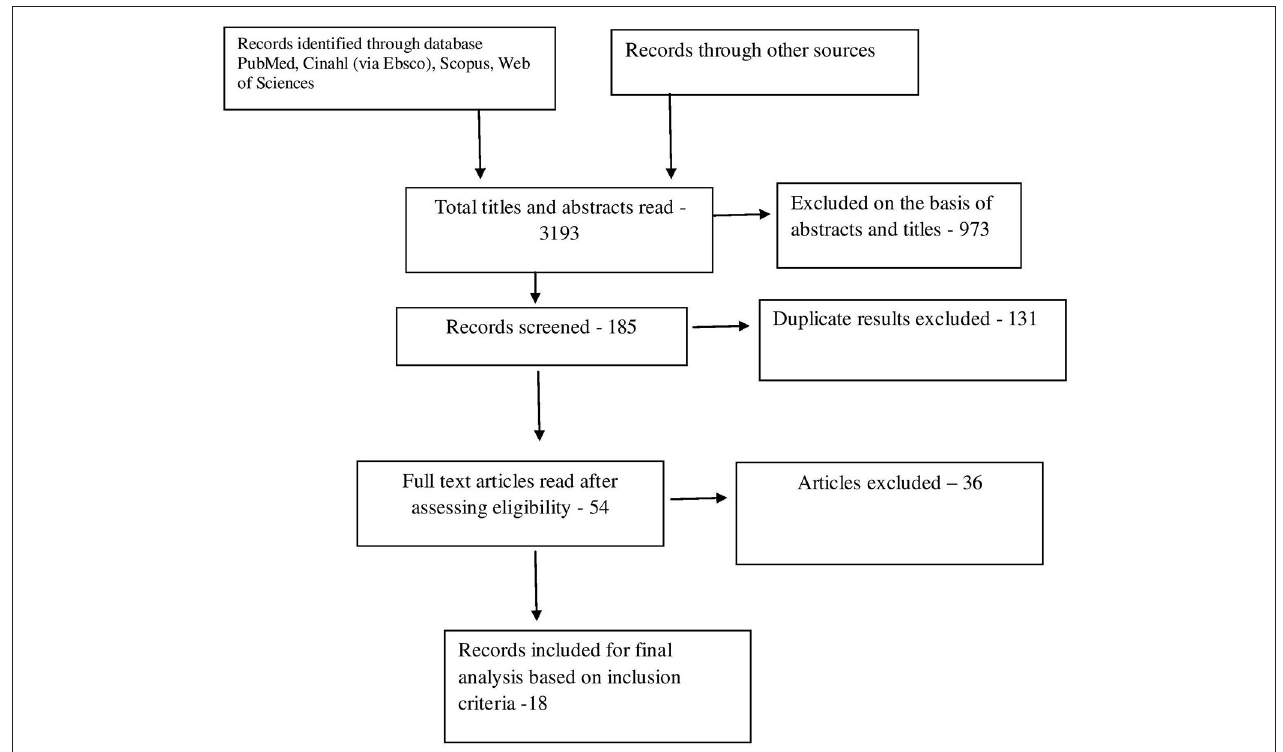
FIGURE 1 | Flow chart diagram for article inclusion based on PRISMA